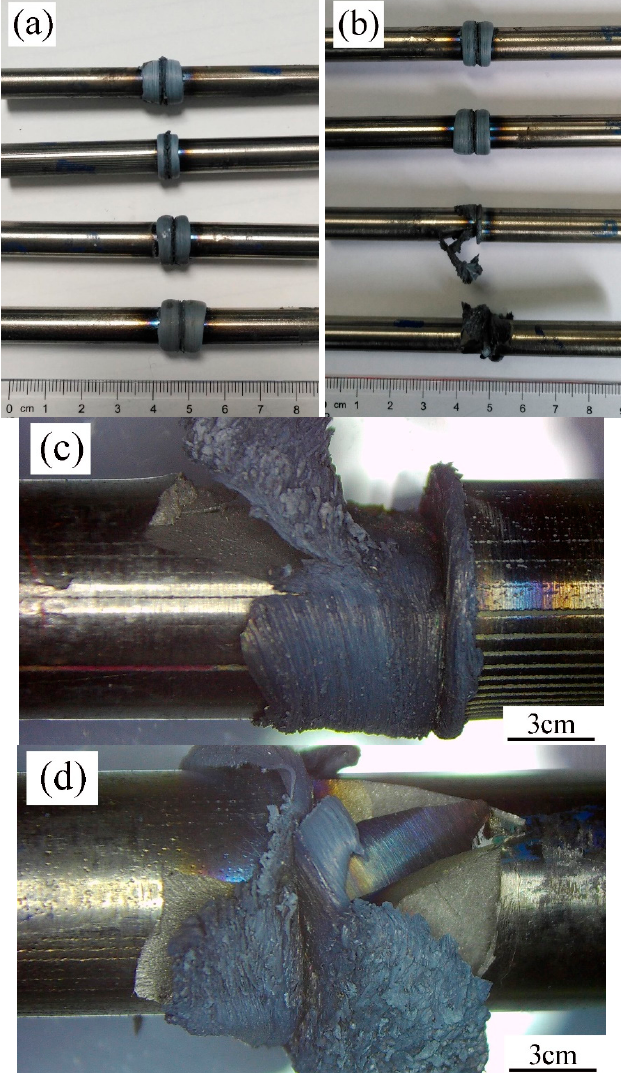
Figure 2. Appearances of the joints of the trial welding specimens: ( a ) Schemes 1–4; ( b ) Schemes 5–8; ( c ) cracking occurring at upset stage in Scheme 7; ( d ) cracking occurring at friction stage in Scheme 8. During the friction stage the heat generated increased, thus the temperature of the friction surface rose, and the length of heated zone increased. When the heat generated by the fraction was